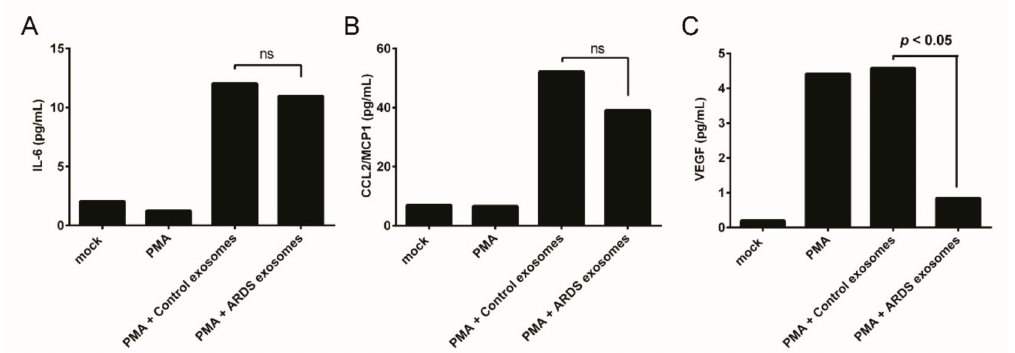
Figure5. CytokinesandchemokinesreleasebyBALexosome-stimulatedcells. ( A )IL-6,( B )CCL2 / MCP1,( C )VEGF release by BAL exosome-stimulated human monocytic THP-1 cells. PMA: phorbol-12-myristate-13-acetate; ARDS: Acute respiratory distress